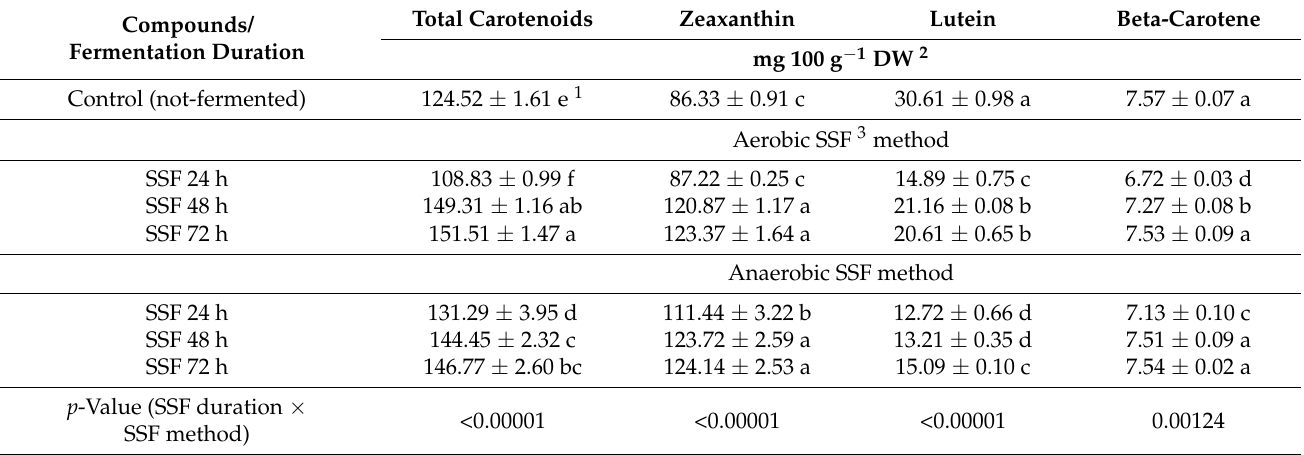
Table 2. The contents of total carotenoids and individual carotenoids in willow herb leaves fermented under the different fermentation methods and